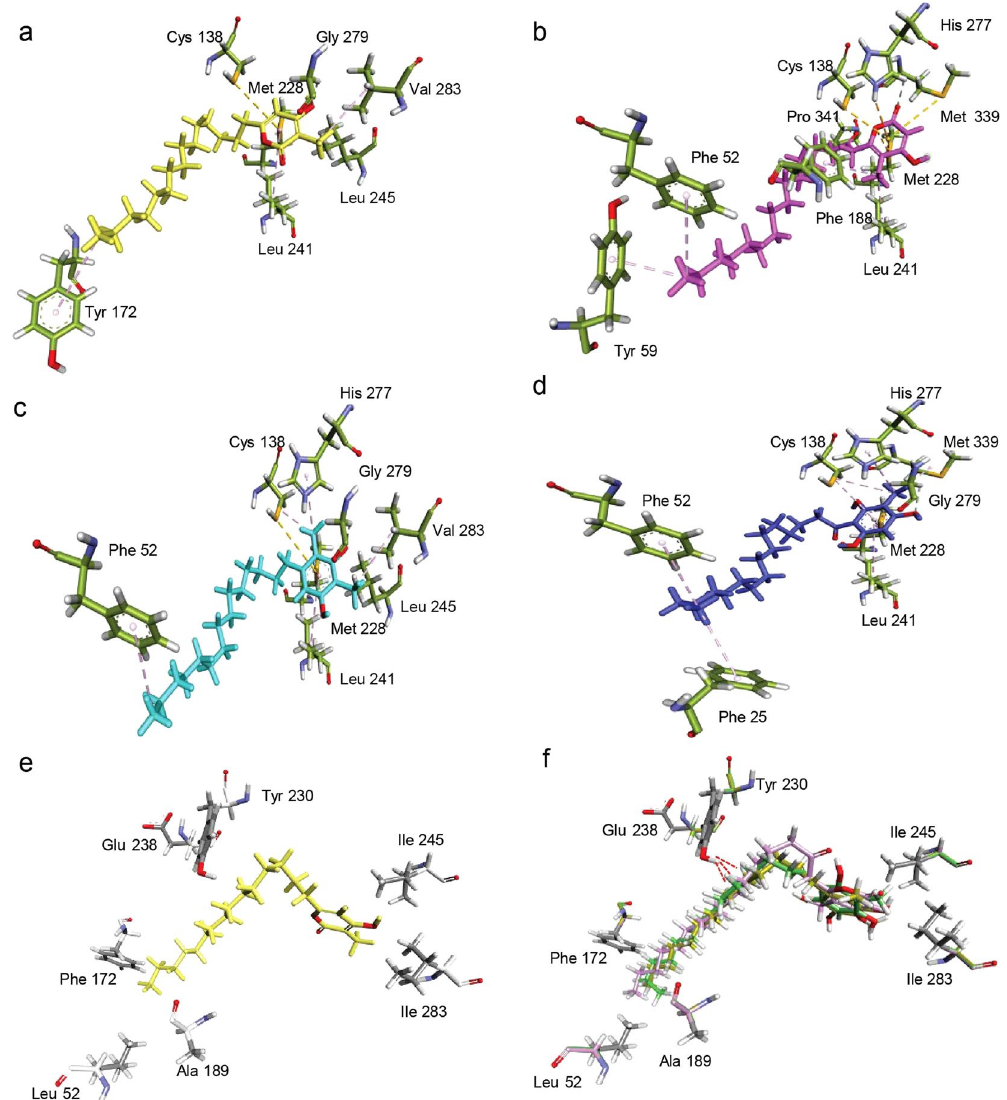
Figure 5. Protein-ligand/product docking studies to delineate structural basis for cyclization specificity in mycobacterial type III PKSs. The products of MMAR_2474 protein were docked in MMAR_2474 homology model. Docking was performed with ( a ) mono-methylated triketide α -pyrone (16a’) ( b ) mono-methylated tetraketide α -pyrone (16b’), ( c ) di-methylated alkyl-resorcinol (16c”) and ( d ) mono-methylated acyl- phloroglucinol (16d’). Interactions with amino acid side chains of MMAR_2474 protein are shown in each case. To identify the structural basis for lack of tetraketide products from MMAR_2470 protein, the cavity lining residues in the MMAR_2474 model were systematically replaced with corresponding amino acid residues in MMAR_2470 protein. ( e ) Shows a mono-methylated triketide α -pyrone (16a’) docked without clashes in the reduced cavity of the mutated MMAR_2474 model. ( f ) Replacement of Trp at position 230 in MMAR_2474 with corresponding Tyr in MMAR_2470 results in a clash with all three tetraketide products (16b’, 16c” and 16d’) docked in the